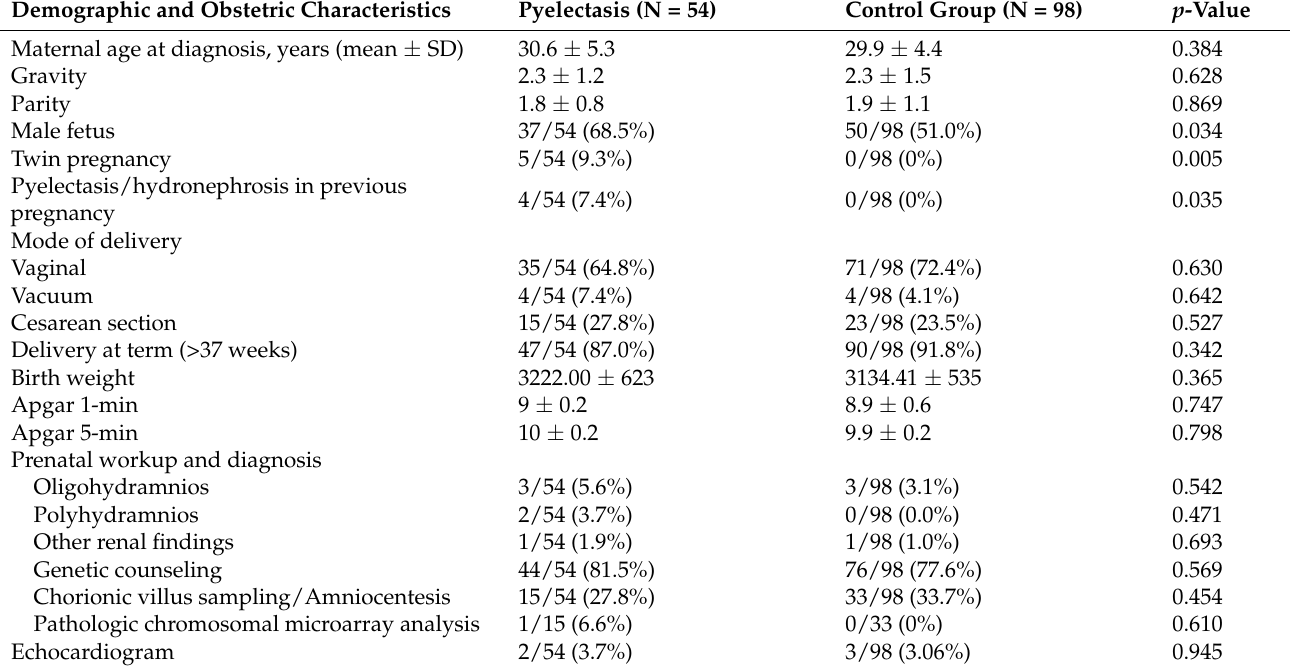
Table 1. Demographic, obstetric and pre-natal work-up of fetuses with pyelectasis vs. control